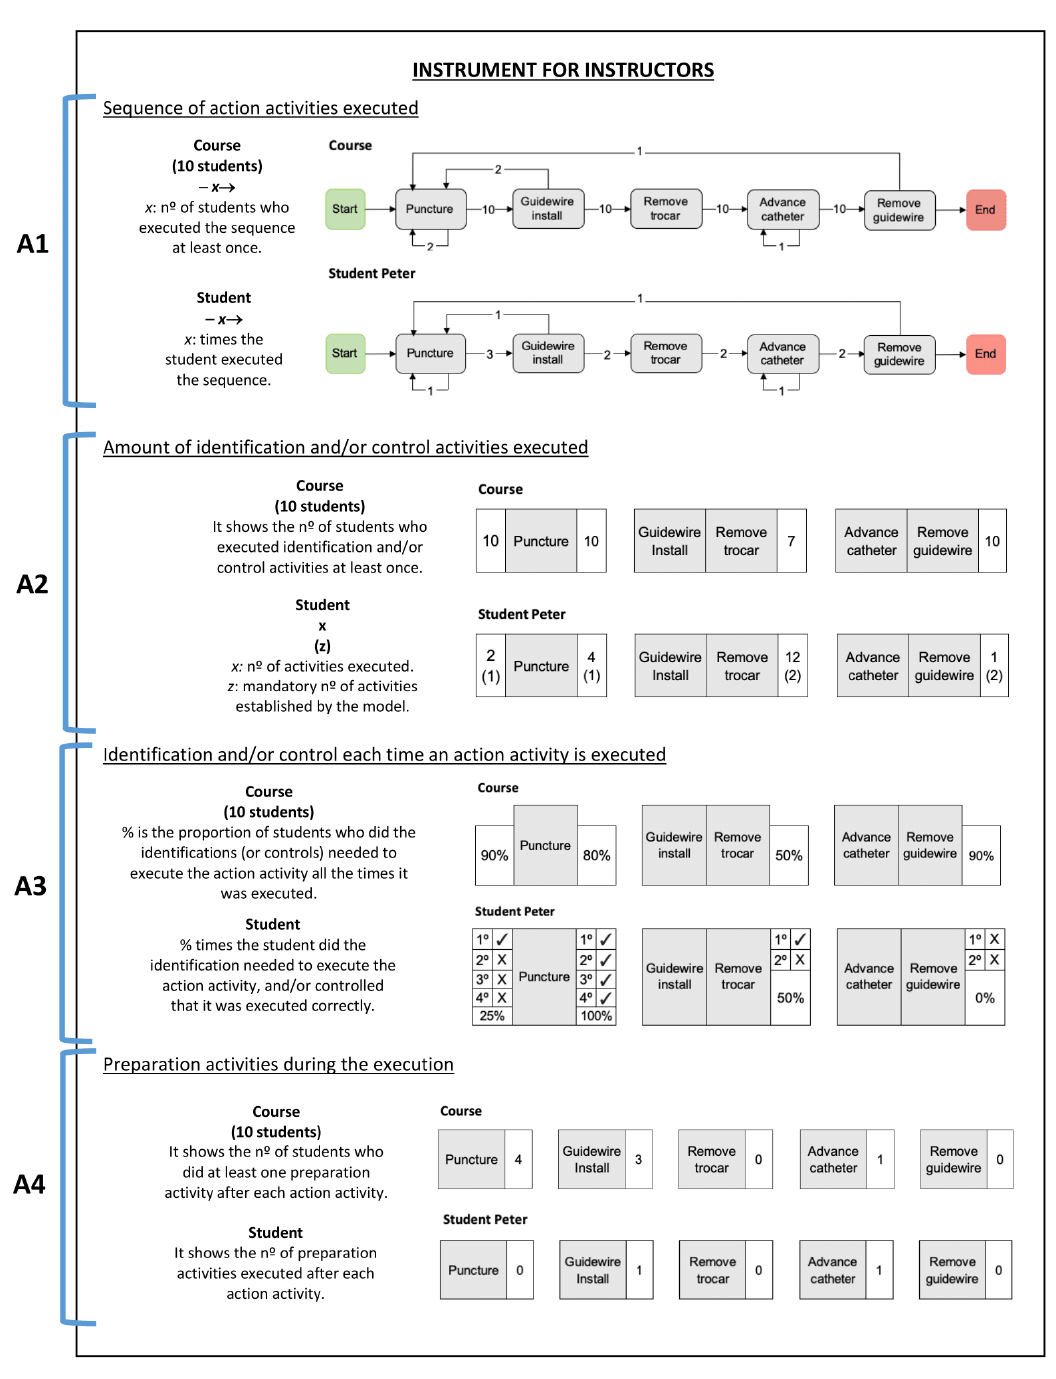
Figure 2. Process-oriented instrument for instructors of surgical